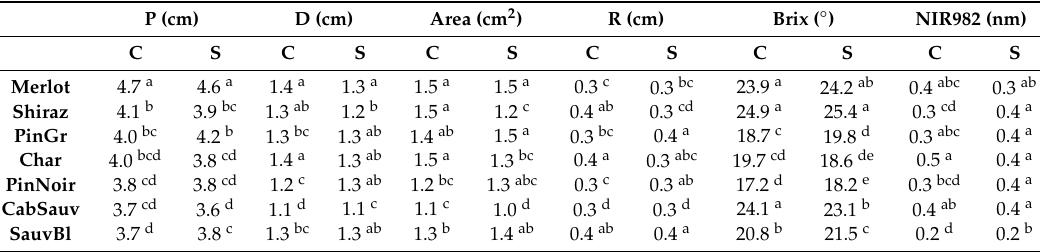
Table 3. Morphometric data obtain from berries for all seven cultivars consisting in Perimeter (P in cm), Equatorial Diameter (D in cm), calculated Area (A in cm2) and Radius (D / 2 in cm). For chemometry, Total Soluble Solids (TSS) represented by Brix and Near Infrared (NIR) absorbance at 982 nm corresponding to H–O–H and O–H chemical